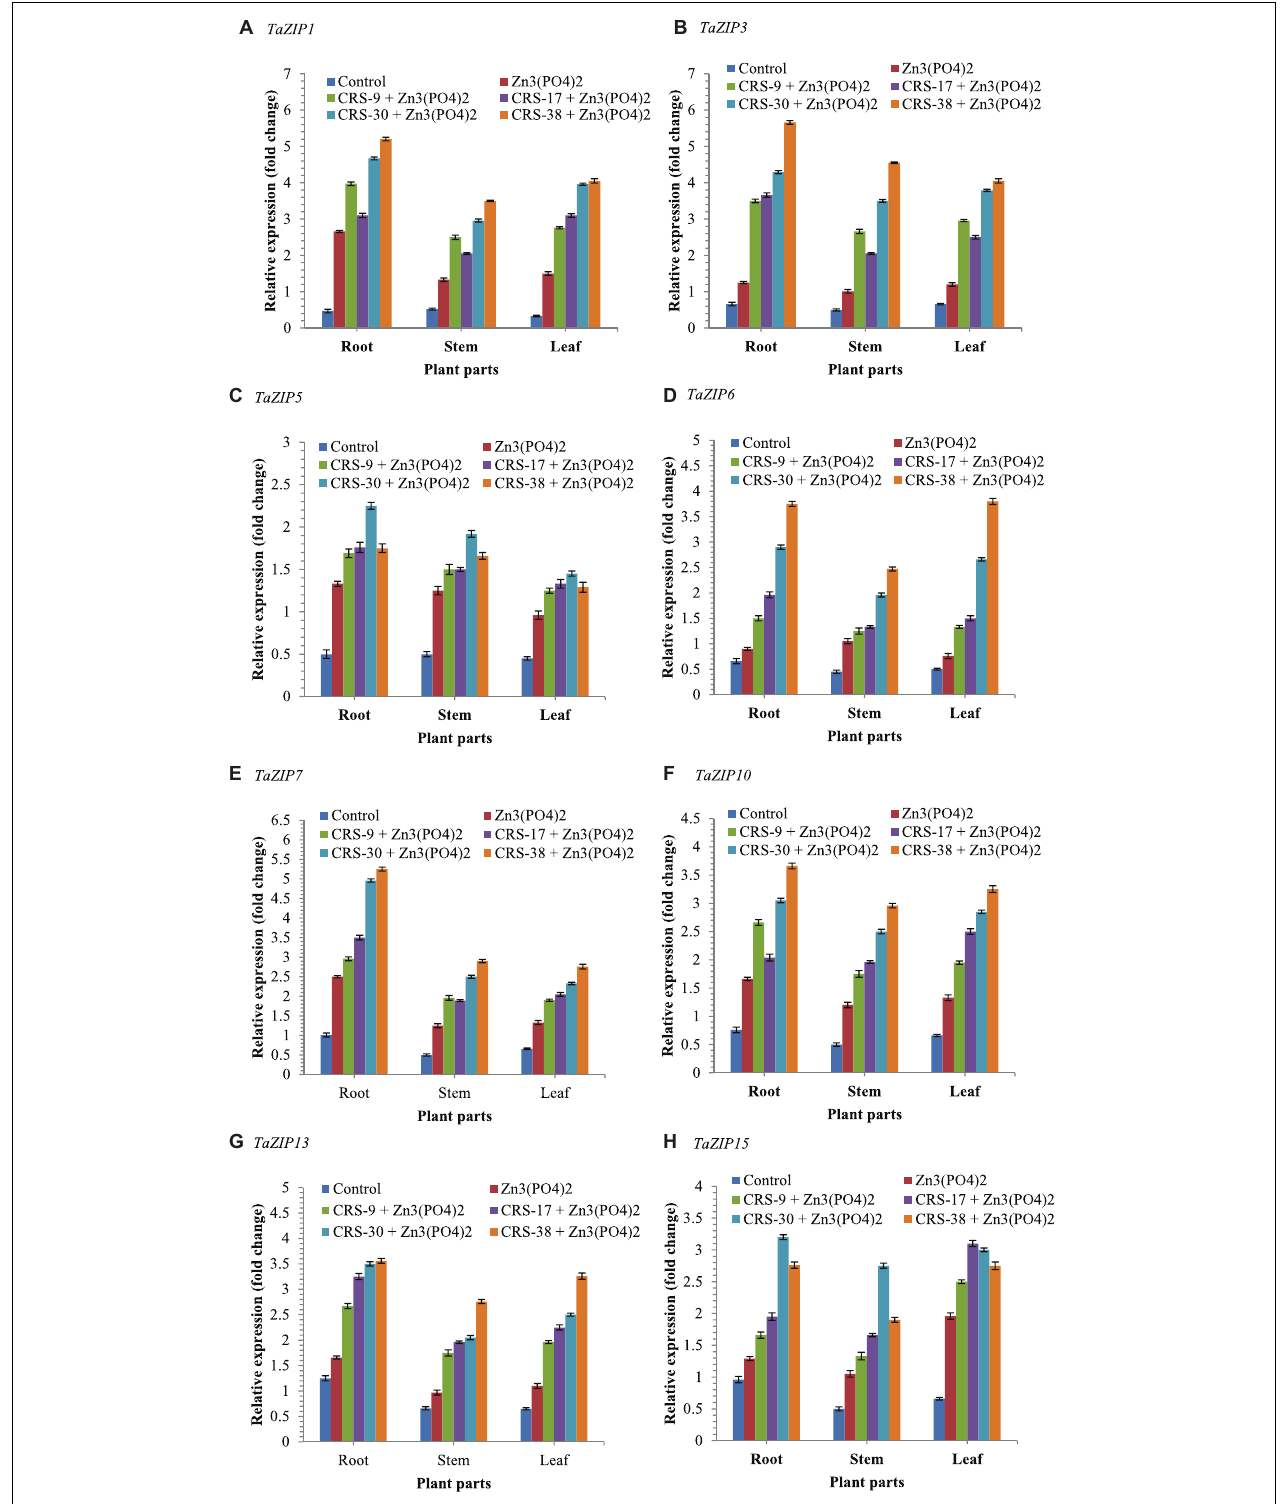
FIGURE 6 | Effects of seed bioinoculation on expression profile of TaZIP transporter genes (fold change) in the wheat root, shoot and leaves grown at 30 days of sowing. (A) Relative expression (fold change) of TaZIP1 , (B) Relative expression (fold change) of TaZIP3 , (C) Relative expression (fold change) of TaZIP5 , (D) Relative expression (fold change) of TaZIP6 , (E) Relative expression (fold change) of TaZIP7 , (F) Relative expression (fold change) of TaZIP10 , (G) Relative expression (fold change) of TaZIP13 , and (H) Relative expression (fold change) of TaZIP15 .